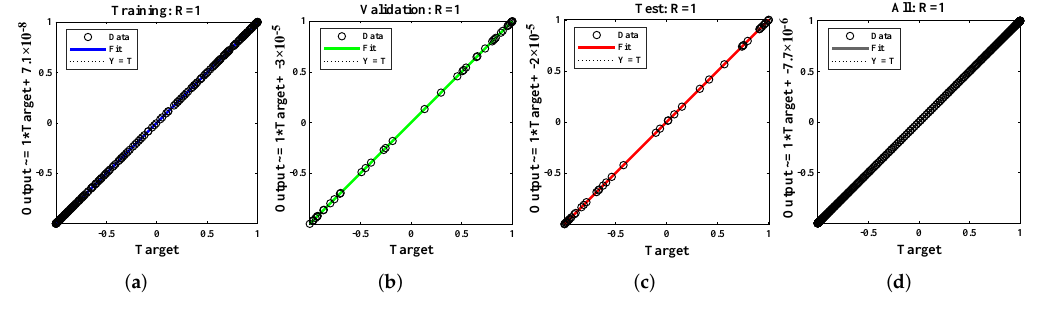
Figure 14. Regression analysis of Example 3. Table 3. Results of velocity ˙ x ( t ) and acceleration ¨ x ( t ) for different examples of the rolling motion of